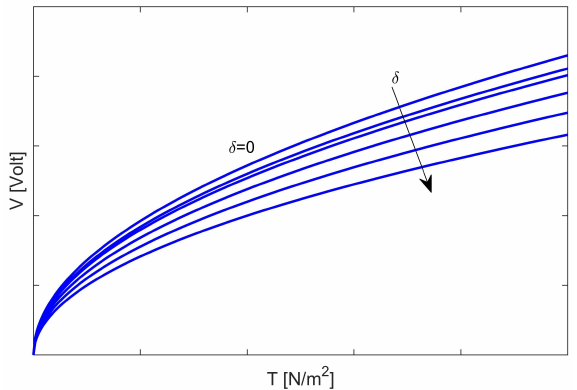
Figure 3. A graphical representation of (32) when δ